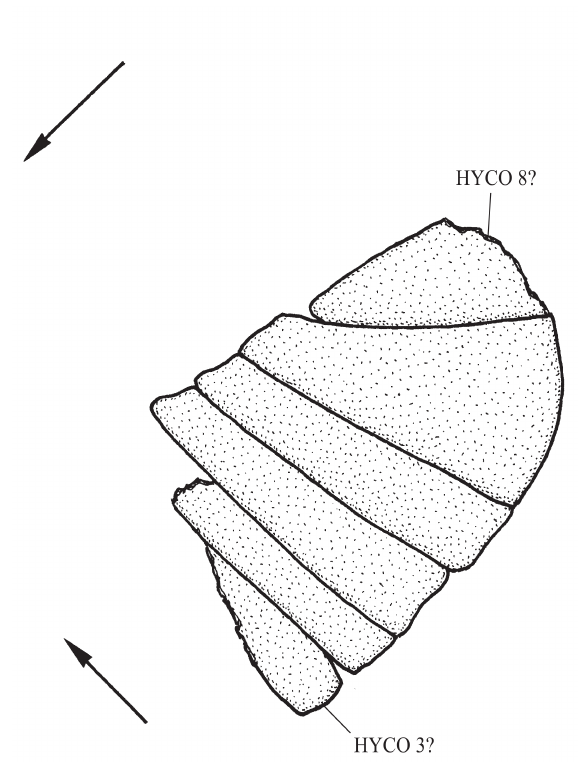
Fig. 10. Joinvillichthys lindstroemi (Davis, 1890). Hypochordal elements of sample CLC S-138. The arrows indicate the position of the most external dorsal and ventral procurrent ray of the caudal